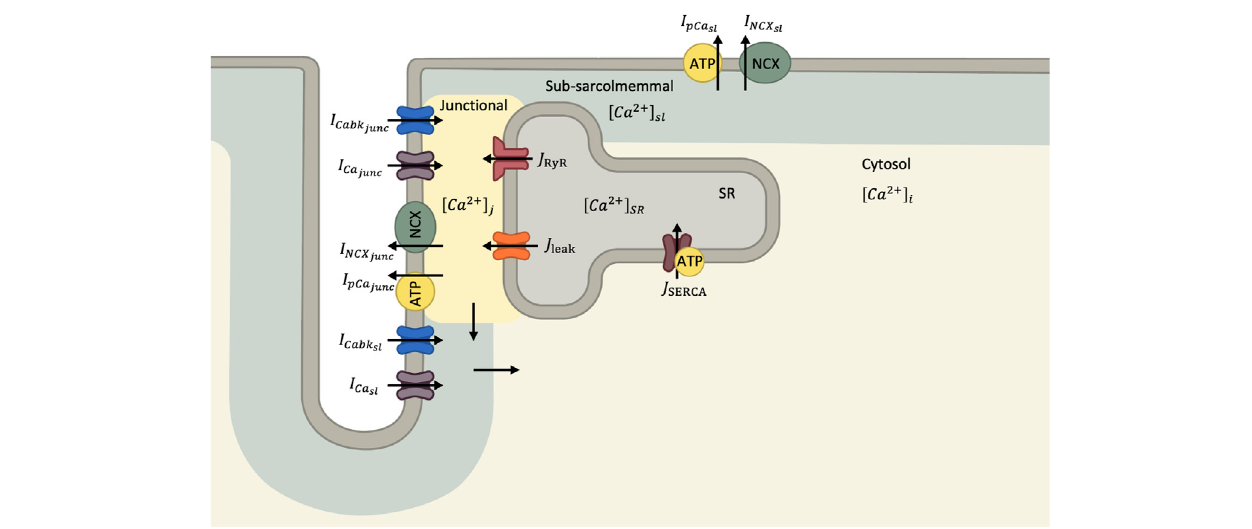
FIGURE1| DiagramofCa 2+ handlingcomponentsinhumanventricularmyocytemodel(Grandietal.,2010).Inthismathematicalmodel, thecytosolisdividedinto junction, sub-sarcolemmal and bulk compartments. Ca 2+ currents through the sarcolemma enter both the junctional and sub-sarcolemmal compartments before diffusing to the bulk